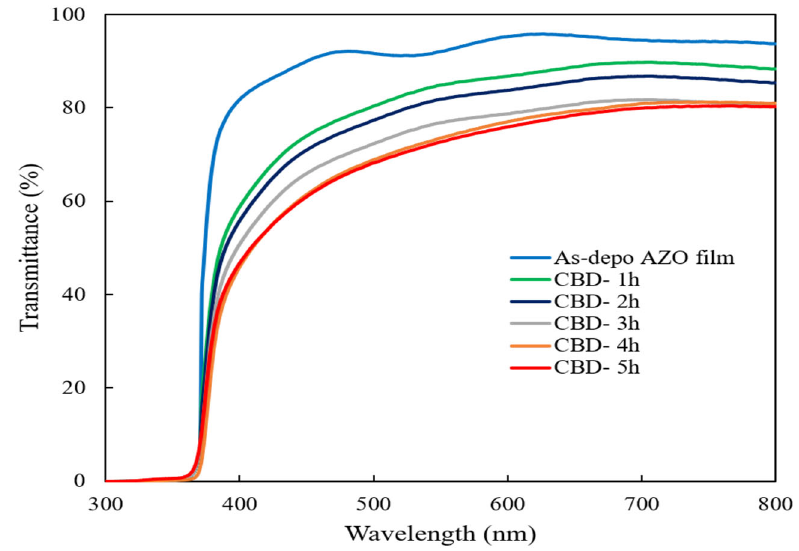
Figure 4. Figure 4. Optical transmittance spectra of ZnO nanorods with different reaction times by CBD method.